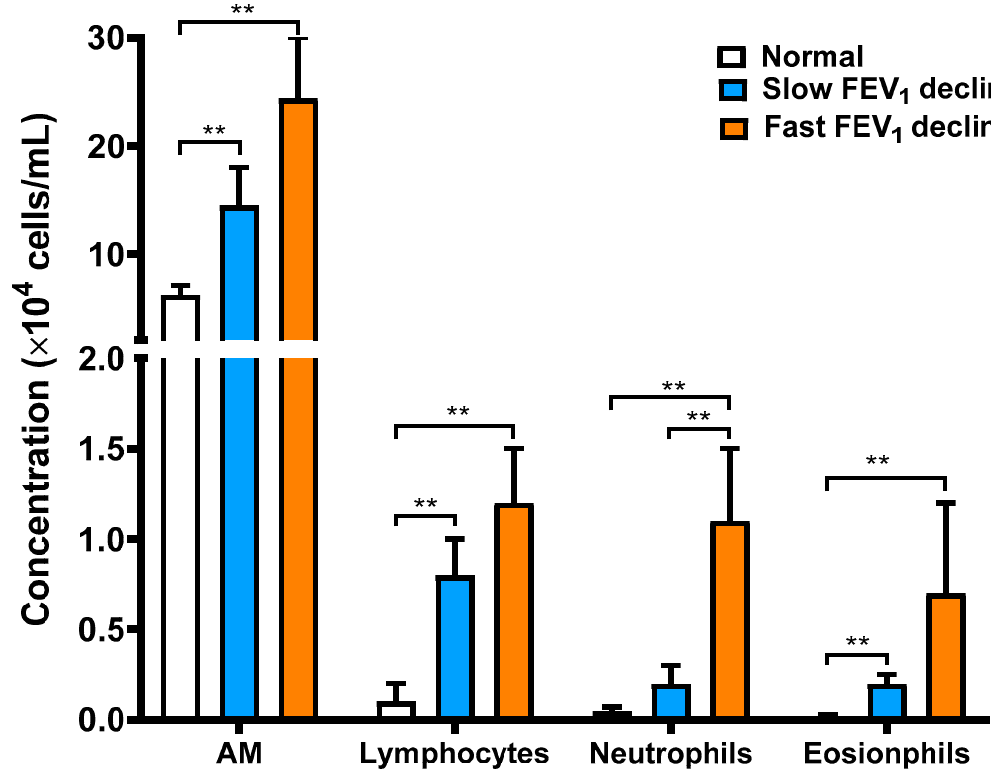
Figure 4. The concentration of different cell types in bronchoalveolar lavage fluid derived from normal subjects (Normal, n = 10), and asthmatic patients with a slow FEV 1 decline (Slow FEV 1 decline, n = 13) or a fast FEV 1 decline (Fast FEV 1 decline, n = 8); ** p < 0.01 is indicated.